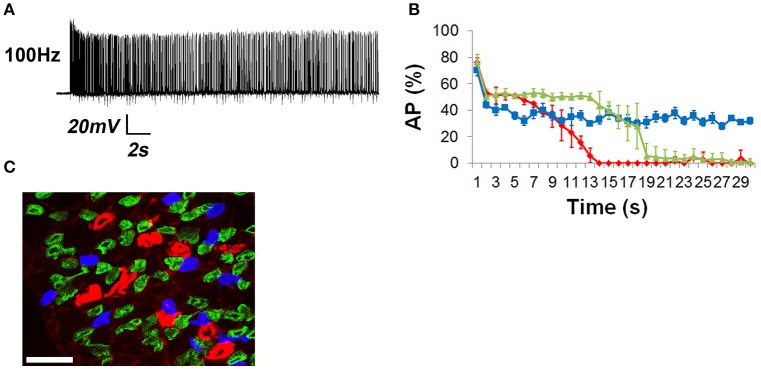
The percentage of muscle APs with defined times to neural transmission failure coincides with the percentage of muscle fibers expressing fatigue-conferring myosin isoforms. (A) Representative trace of a muscle fiber exhibiting only intermittent failure for the entire 30-s period in response to 100 Hz stimulation. Note the difference between this cell and that in Figure 2A. (B) When cells were plotted individually according to when they exhibited NTF, three subpopulations emerged, those exhibiting failure near 10 s (blue), those near 20 s (green), and those only displaying partial failure even after 30 s, similar to the trace in (A); (blue line). (C) Fresh-frozen cross sections of muscle stained with antibodies recognizing Type I, slow, oxidative MHC (blue), Type IIA fast fatigue-resistant, glycolytic/oxidative MHC (green), and Type IIB fast-fatiguable glycolytic MHC (red), or no antibody labeling (Type IIx). Scalebar = 100 μm. The relative percentage of these myosin-expressing subpopulations is similar to the relative percentage of muscle subpopulations fatiguing in response to 100 Hz at different times, as shown in (B).